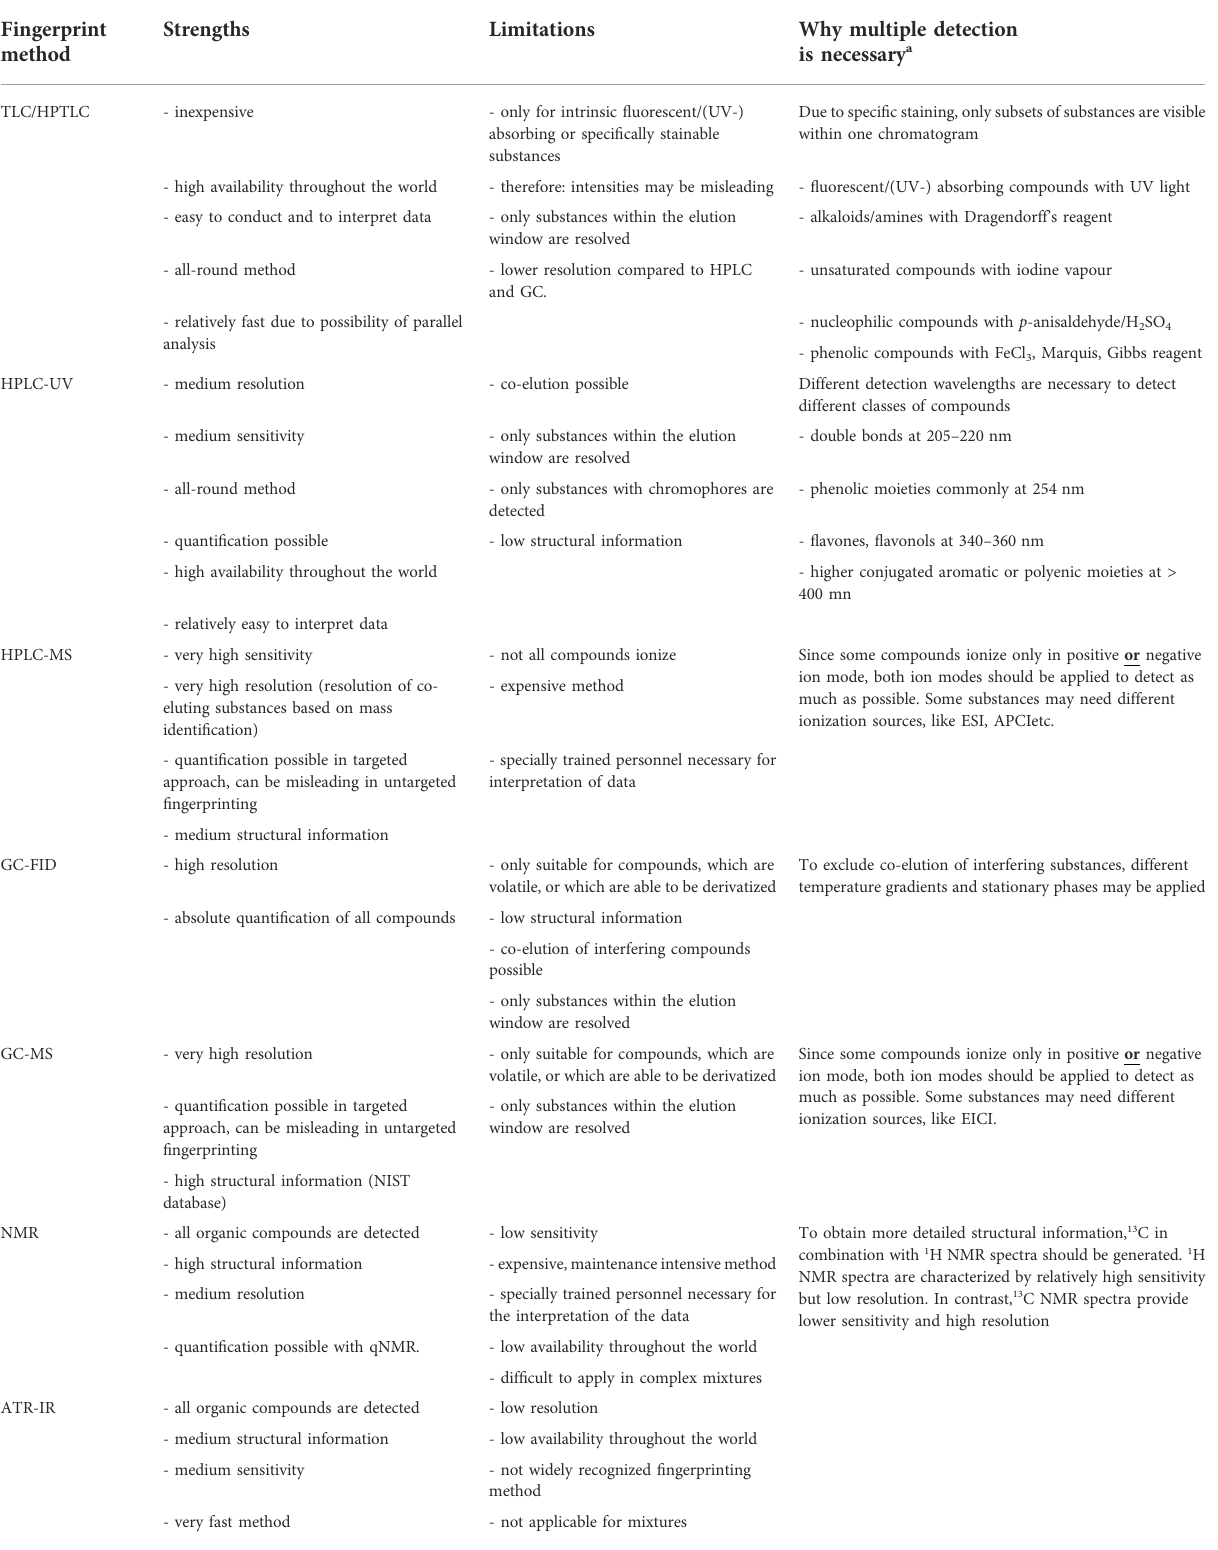
TABLE5Strengthsandlimitationsofthemostsuitableanalyticalmethodsforde fi ningthechemicalpro fi lefordifferenttypesofextractsbasedonthe current